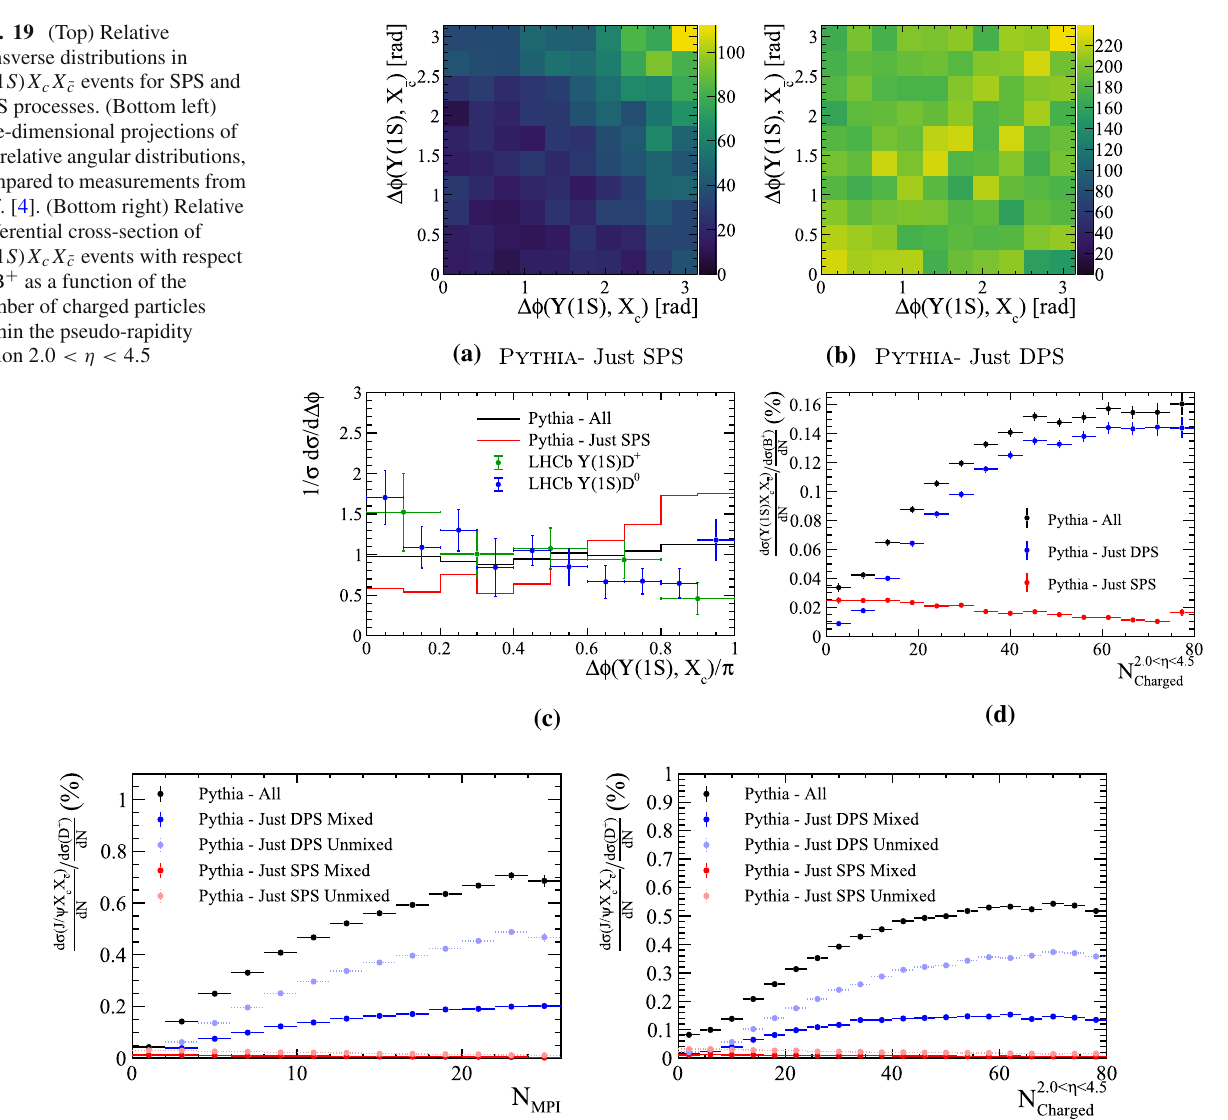
Fig. 20 Ratio of differential cross-section of J / ψ X c X c and D + hadrons as a function of (left) the number of parton interactions in a collision and (right) the number of charged particles within the pseudo-rapidity region 2 . 0 < η < 4 . 5, as generated with